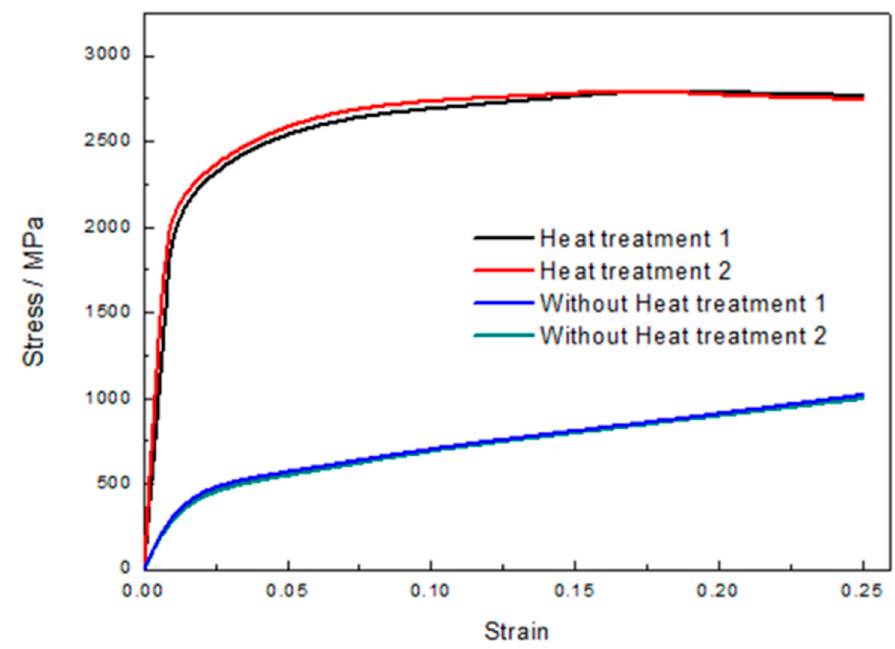
Figure 4. Stress-strain curve of H13 steel at room temperature.